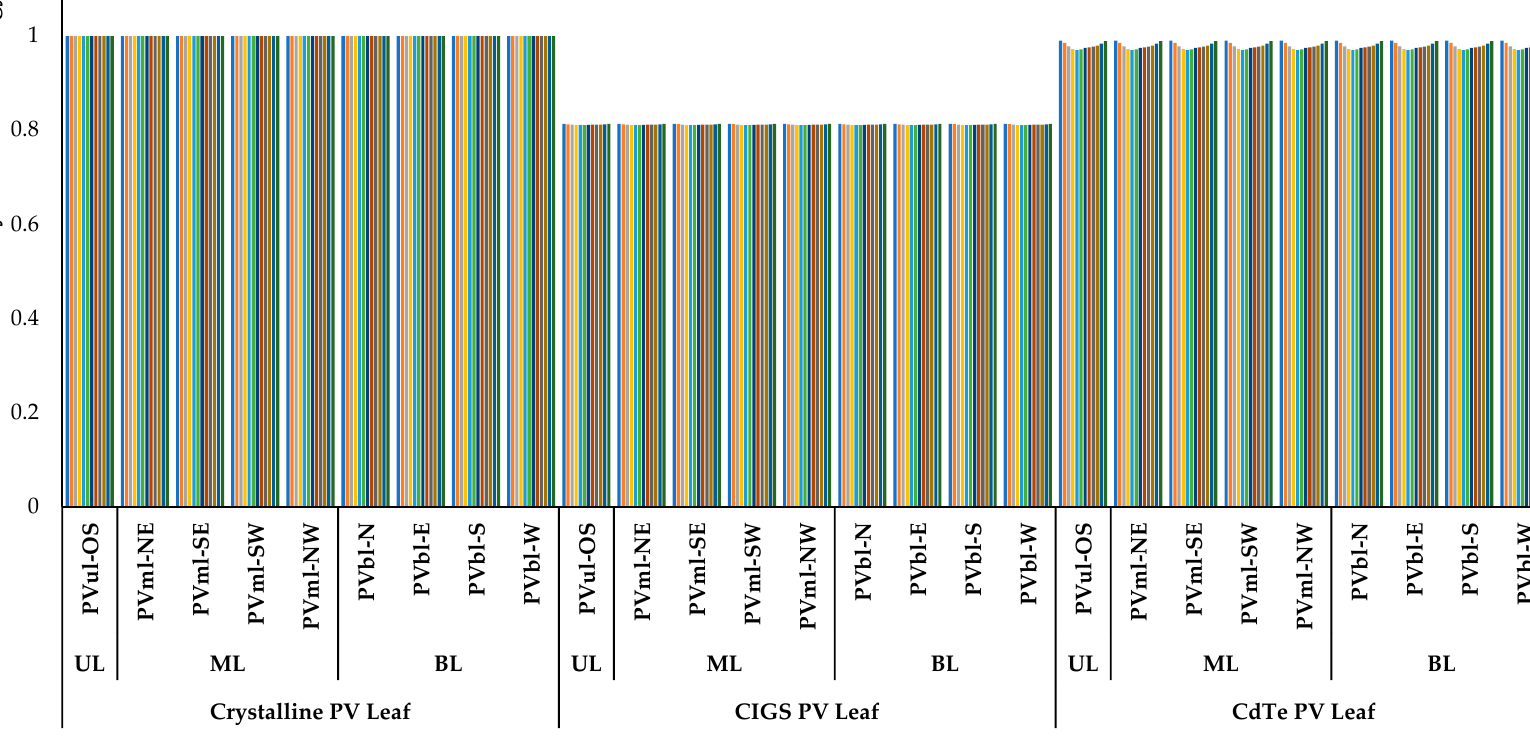
Figure 9. Comparison of normalized monthly energy outputs of a solar photovoltaic tree in three different layers for the three different c-Si, CIGS, and CdTe solar cell technologies.